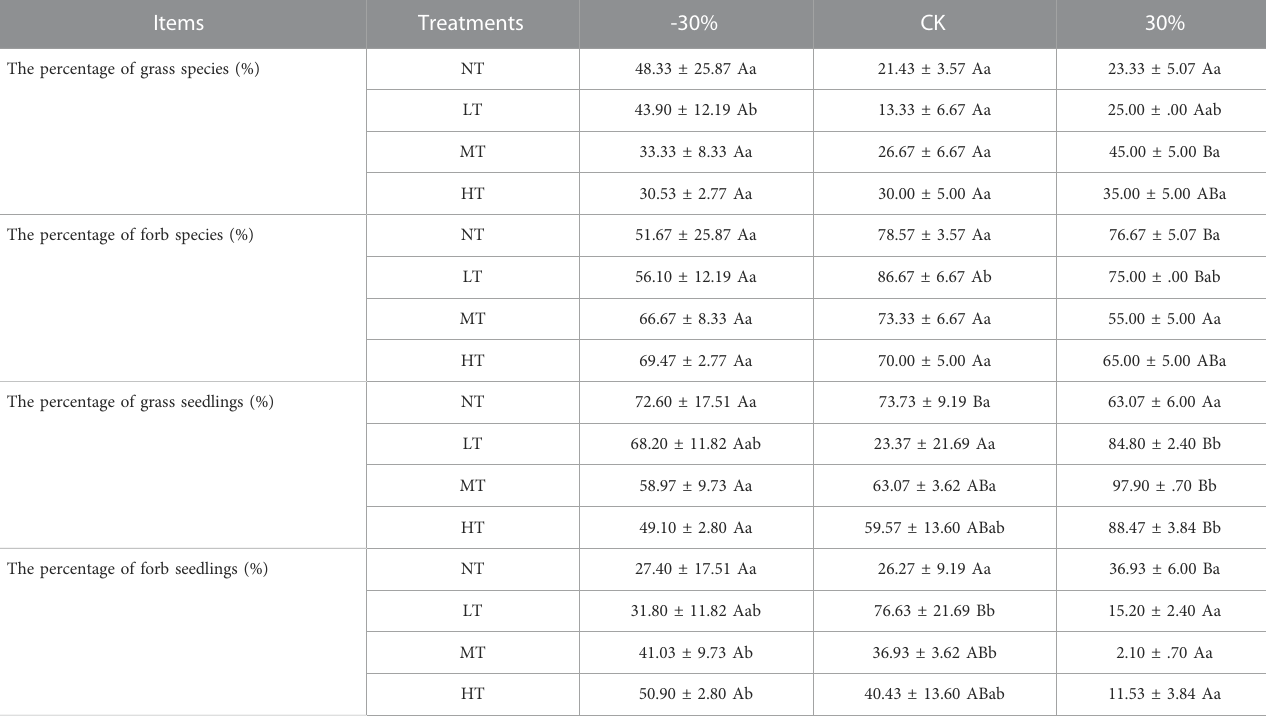
TABLE 1 Effects of precipitation changes and trampling intensities on functional composition. Items